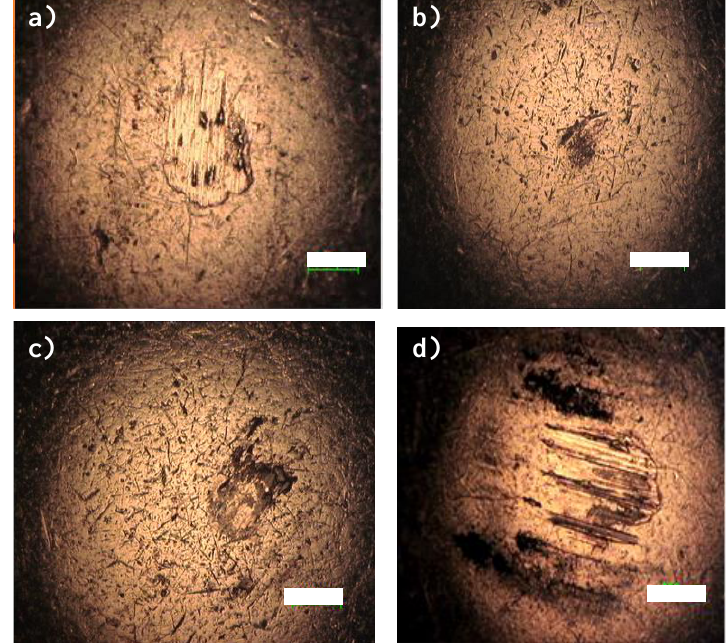
Figure 10. Optical macrographs of the steel balls after the tribology tests, at 200 °C, with the carbon coatings: ( a ) Cu-C15, 500 cycles; ( b ) Cu-C15, 150 cycles; ( c ) Cu-C60, 500 cycles; ( d ) Cu-C100, 500 cycles (bar = 200 μm).